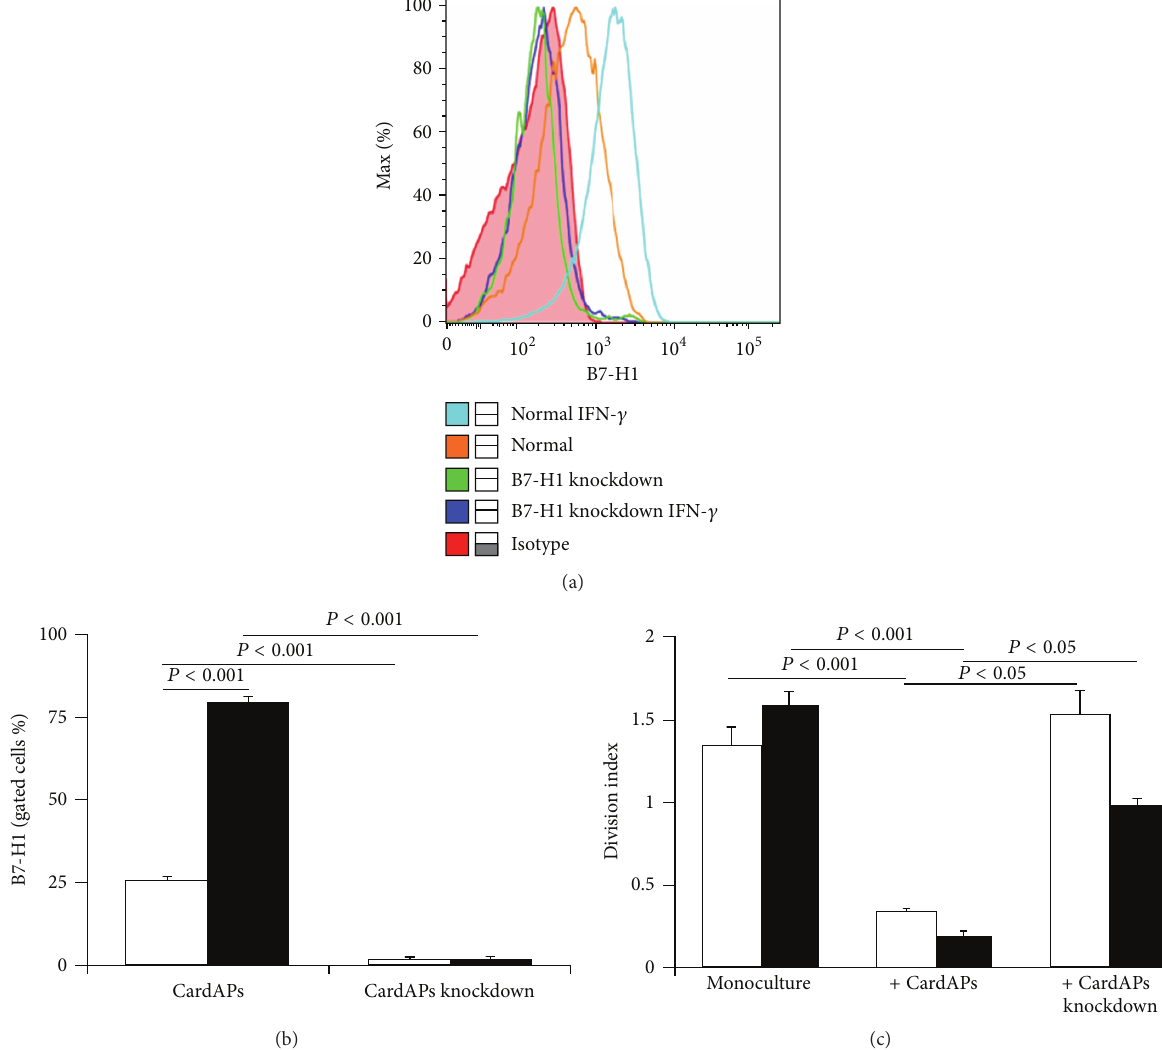
Figure 1: Cardiac-derived cells reduce T-cell proliferation in a cell-contact-dependent manner involving the receptor B7 H-1. (a) Expression of B7-H1 on CardAPs after specific siRNA knockdown. Red coloured histogram represents isotype control, the orange line indicates the expression of B7-H1 on CardAPs under basal conditions. The light blue line represents B7-H1 expression after exogenous stimulation with 5ng/ml of human IFN- 𝛾 . The green line shows absence of B7-H1 expression after its specific siRNA knockdown, which even upon IFN- 𝛾 treatment was not restored (dark blue line). (b) Bar graphs represent the mean ± SEM of B7-H1 positive CardAPs or CardAPs after specific siRNA knockdown of B7-H1, as indicated, depicted as the % of gated CardAPs, under basal culture conditions (open bars) and after 72 h treatment with human IFN- 𝛾 (closed bars) with 𝑛 = 4 /group. (c) The immunosuppressive function of CardAPs is mediated via B7-H1. Spleen MNCs from control (open bars) and CVB3-infected (closed bars) mice were activated and labeled with 10 𝜇 M of CFSE to be able to measure cell proliferation, and cultured for 48 h in the absence or presence of CardAPs or CardAPs of which B7-H1 was knocked down, followed by flow cytometry and analysis with FlowJo 8.7. software. Bar graphs represent the division index of spleen MNCs from control and CVB3- infected mice co-cultured for 48 h in the absence or presence of CardAPs or CardAPs of which B7-H1 was knocked down, as indicated, with 𝑛 = 4